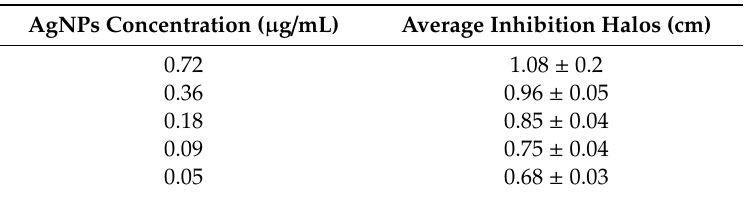
Table 4. Halos of average inhibition in Pseudomonas aeruginosa cultures at different concentrations of